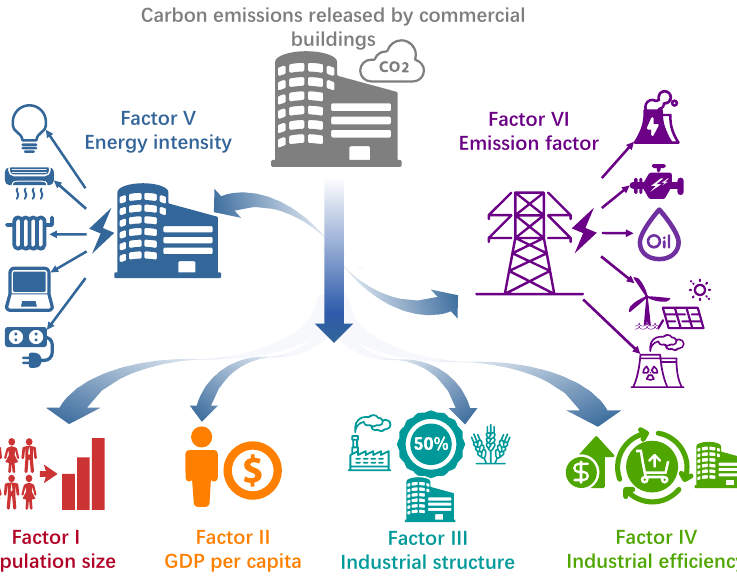
Figure 2. Six factors guided by the Kaya identity in an emissions model of a commercial building operation.